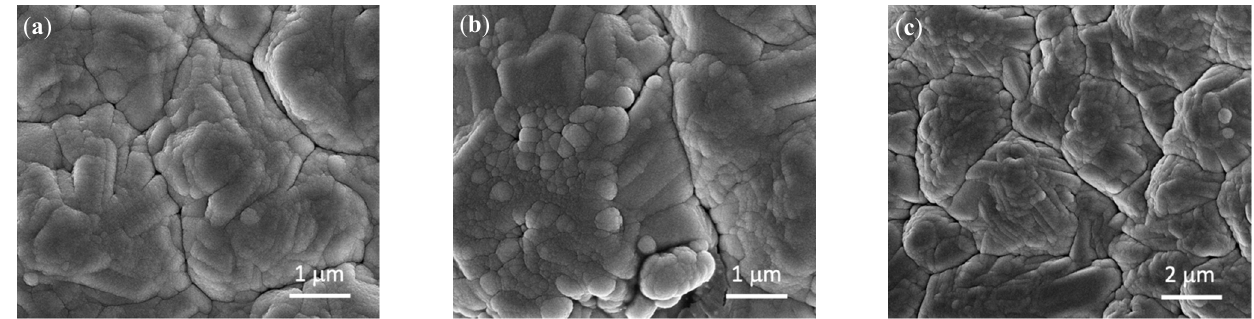
Figure 4. SEM images of ( a ) Si@Cu, ( b ) Si 3 N 4 @Cu, and ( c ) Si 3 N 4 @Si@Cu thin films prepared by RF sputtering.